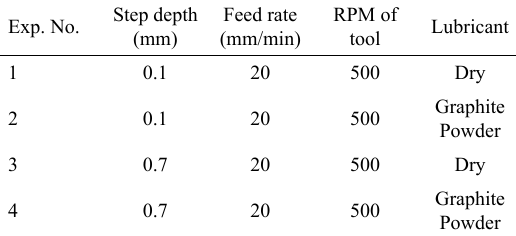
Table 1. Process parameters of